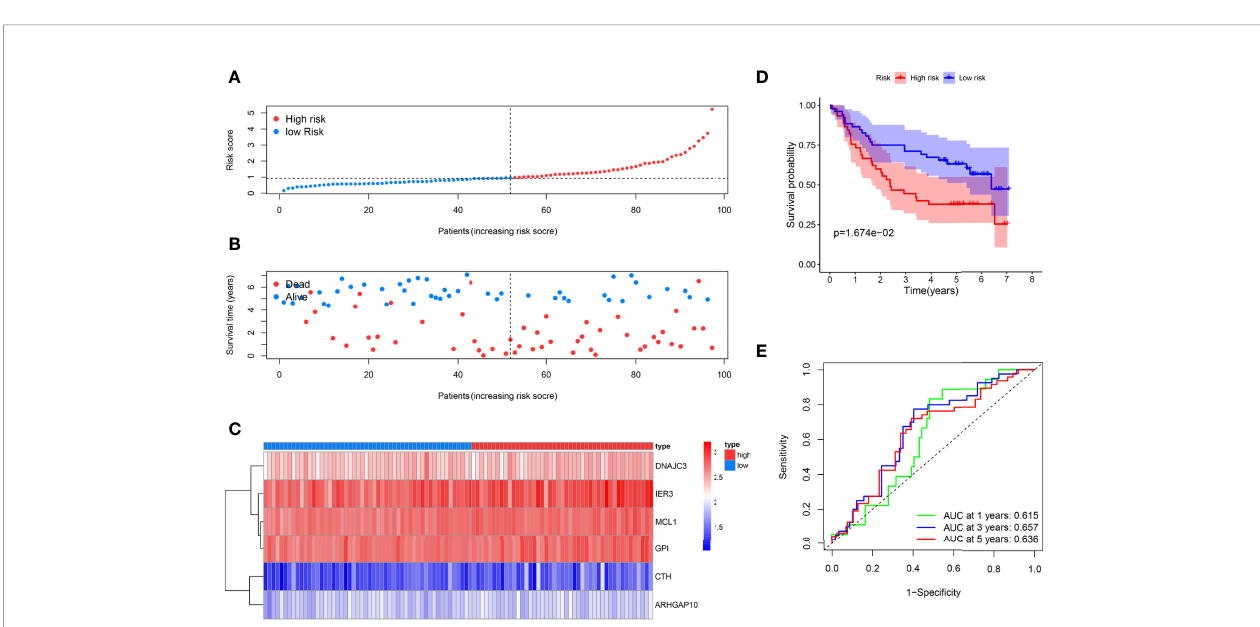
FIGURE 4 | External testing of the ARG model. (A) Patient with different risks were separated into two groups via the same median risk score in the internal database. (B) Patients in the external dataset with different survival times and statuses were arranged by the increasing risk score from left to right. (C) The heatmap of the six risk ARGs in the external database showed the same expression pattern. (D) Kaplan – Meier analysis showed different prognoses between the two groups as well. (E) The ROC curves of the models for survival rate in the external testing